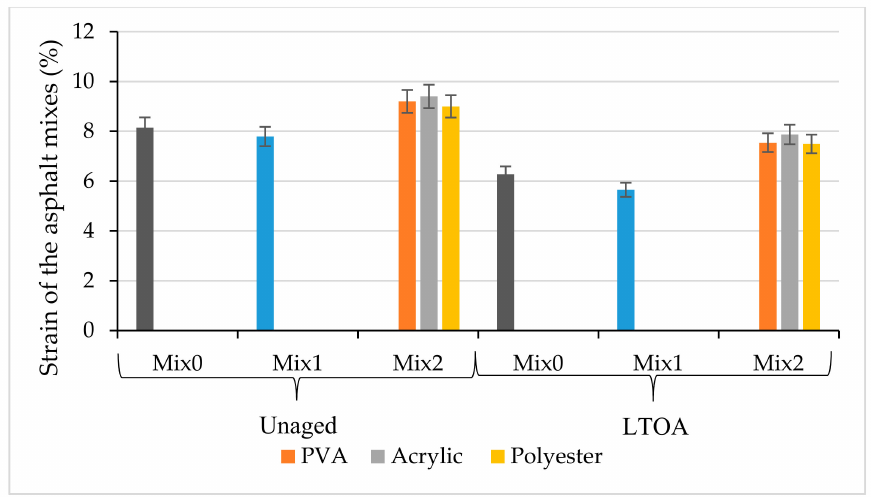
Figure 9. Strain of the asphalt